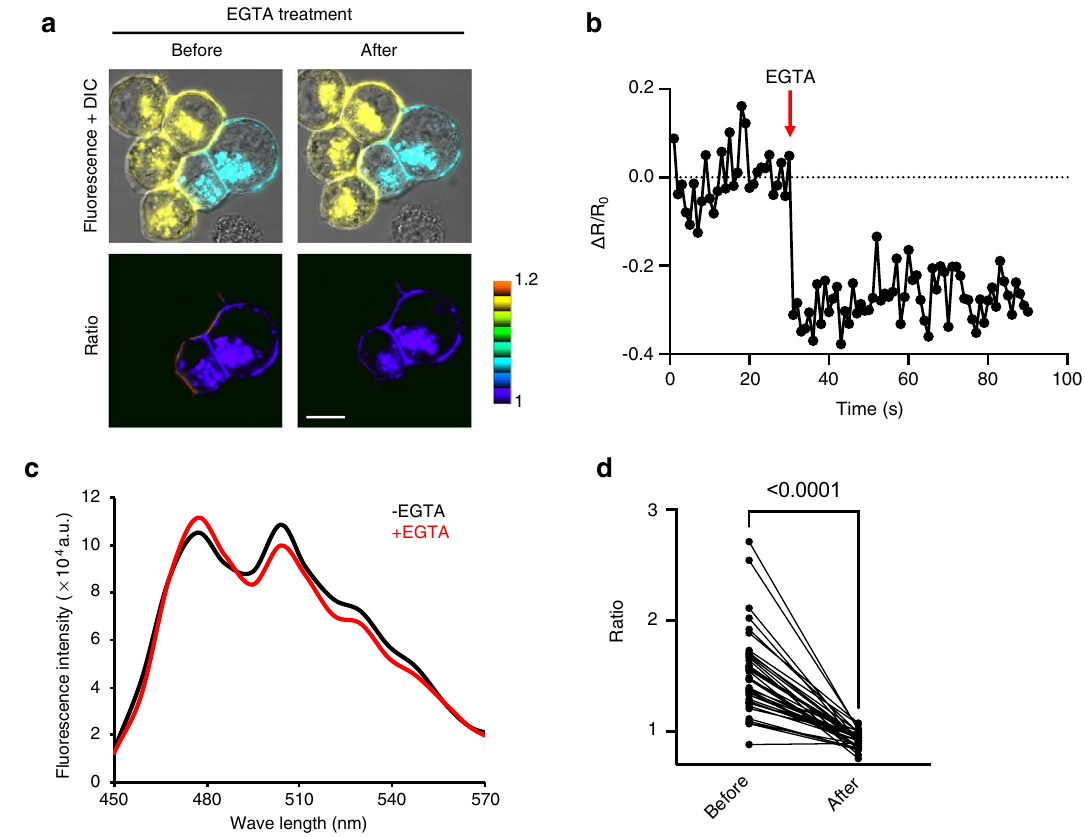
Figure 4. Ca 2+ -dependency of γB2 trans interaction. ( a ) The effect of EGTA treatment on the FRET at the cell adhesion sites. K562 cells individually expressing the FRET-based γB2ΔICD indicators were co-cultured. The merged fluorescence and DIC images (upper panels) and the ratio images of Venus/mTQ2 (lower panels) were acquired before and after 5 mM EGTA treatment. Scale bar, 10 μm. ( b ) Change in Venus/mTQ2 ratio (ΔR/R 0 ) at a cell adhesion site with EGTA treatment over time. EGTA (5 mM) was added to the medium at 30 s. R 0 was calculated as the average Venus/mTQ2 ratio value of 30 frames before EGTA treatment. ( c ) Emission spectra before and after EGTA treatment. The emission spectra excited by 405 nm light at the cell adhesion site before and after 5 mM EGTA treatment were acquired. ( d ) Quantitative analysis of ratio changes by EGTA treatment. The FRET ratio values at the cell adhesion sites before and after 5 mM EGTA treatment were measured ( n = 38). Significant difference was analyzed by Wilcoxon matched-pairs signed rank test. p value is indicated in the